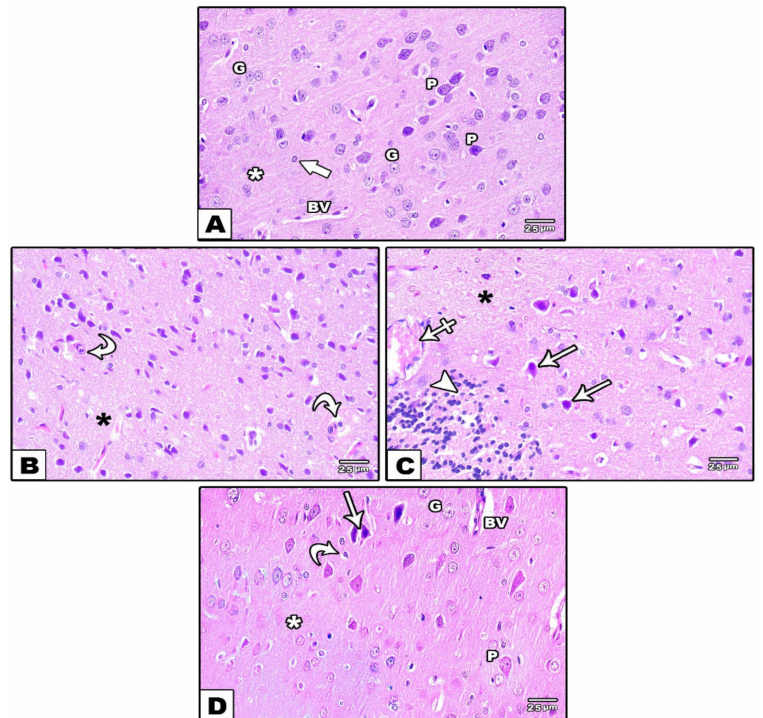
Figure 5. Photomicrographs of sections in the cerebral cortex stained with H& E. ( A ): In the control groups, large pyramidal cells and scattered granular ones can be observed. The pyramidal cells (P) have long apical dendrites, basophilic cytoplasm, and large vesicular nuclei. The granular cells (G) have rounded cell bodies with large rounded vesicular nuclei. The neuropil (white asterisk) contains the nuclei of neuroglial cells (thick arrow) and normal blood vessels (BV). ( B , C ): In the reserpine-treated group, ( B ) apoptotic cells (curved arrows) with small darkly stained nuclei and little acidophilic cytoplasm with vacuolation (black asterisk) in the neuropil are observed. ( C ): Perineuronal empty spaces (arrows) around deformed and shrunken pyramidal cells are visible. Vacuolation (black asterisk), inflammatory cellular infiltration (arrowhead), and dilated congested blood vessels (crossed arrow) are noticed in the neuropil. ( D ): In the fisetin-treated group, normal pyramidal (P) and granular (G) cells are seen. Few shrunken cells (arrows) with dark nuclei and perineuronal empty spaces and few apoptotic cells (curved arrow) are noticed. Normal neuropil (white asterisk) with non-congested blood vessels (BV) is